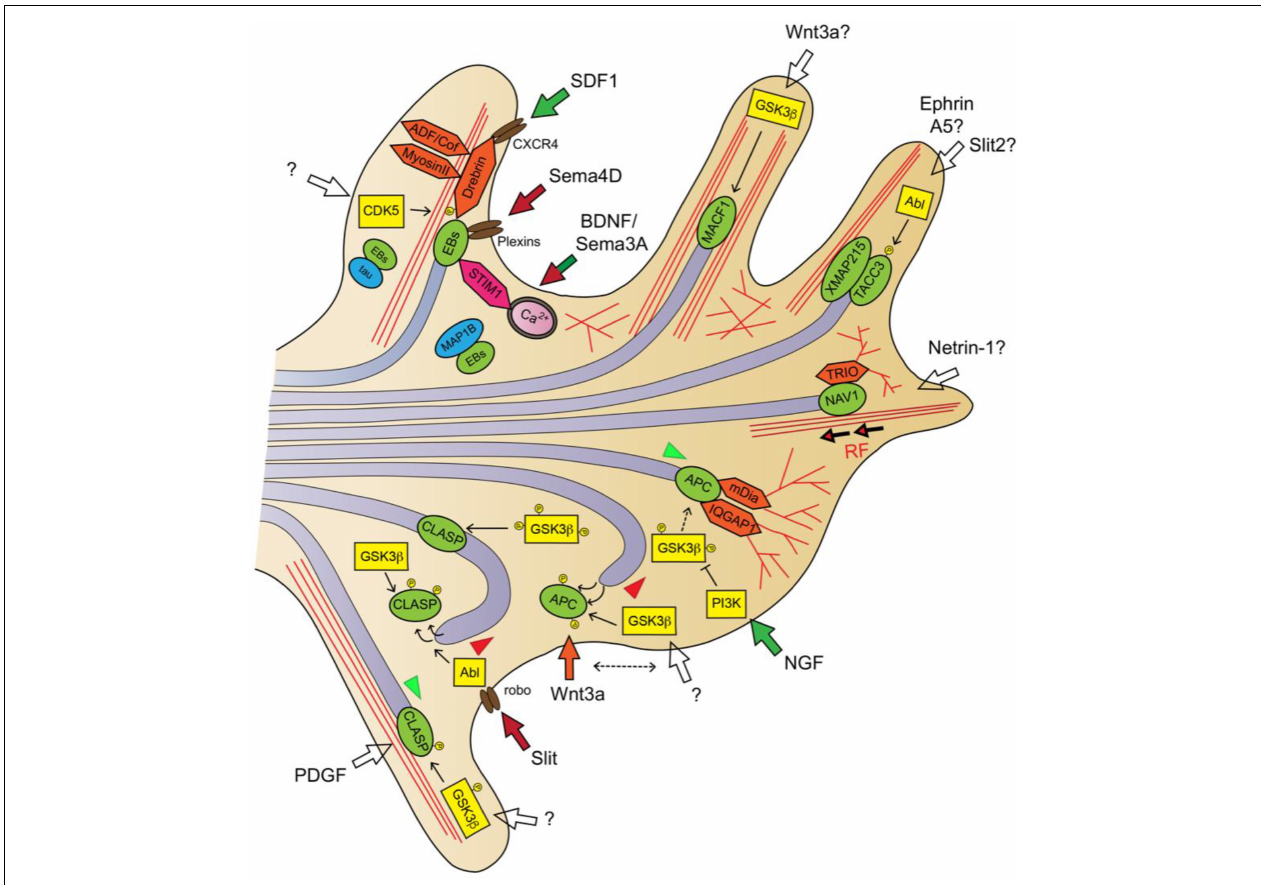
FIGURE 3 | Guidance signaling downstream pathways involved in MT dynamics in the axon and GC II: +TIPs. SDF1/CXCR4 signaling activates the EB1/Drebrin module for MT remodeling (Shan et al., 2021). Sema4D/plexin signaling inhibits EB3-labeled MT polymerization (Laht et al., 2012, 2014). BDNF and Sema3A promote asymmetric MT invasion via STIM1-EB3 interaction (Pavez et al., 2019). NGF stimulates APC-dependent MT plus-end stabilization via local inhibition of GSK3 β activity (Zhou et al., 2004). Wnt3a alters MT polymerization direction by misslocating APC from the MT plus-ends (Purro et al., 2008). Slit/Robo signaling promotes MT growth arrest by dissociating CLASP from the MT plus-end via Abl-dependent CLASP phosphorylation (Lee et al., 2004). High GSK3 kinase activity (poorly phosphorylated) dissociates CLASP from plus-ends, low GSK3 activity (highly phosphorylated) misslocates CLASP from plus-ends to the MT lattice, moderate GSK3 activity allows CLASP plus-end binding, MT stabilization and growth (Hur et al., 2011a). MTs are shown as light purple tubes, F-actin as red lines. +TIPs are represented in green, kinases in yellow, actin-interacting/regulatory proteins in orange and other +TIP-interacting proteins in pink. Guidance cue receptors are in brown. Guidance-evoked responses are represented in green (attraction), red (repulsion) or orange (pause) arrows. Empty arrows were used when downstream transduction pathways are unclear or guidance cues unknown. MT advance and retraction are represented with green and red arrowheads,